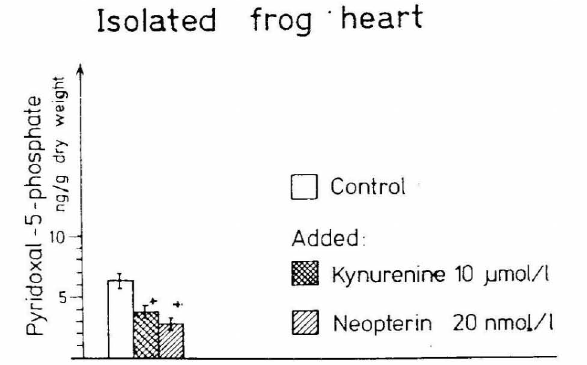
Figure 2. Concentrations (mean± S.D.) of pyridoxal-5-phos phate (P-5-P) in control frog heart tissue (D) and in frog heart tissue incubated with incubation medium containing \0 /lmol/I L-kynurenine (1m). or 20 nmol/I D-neopterin (~) 30 for min. *The changes are statistically significant (p<O.Ol).